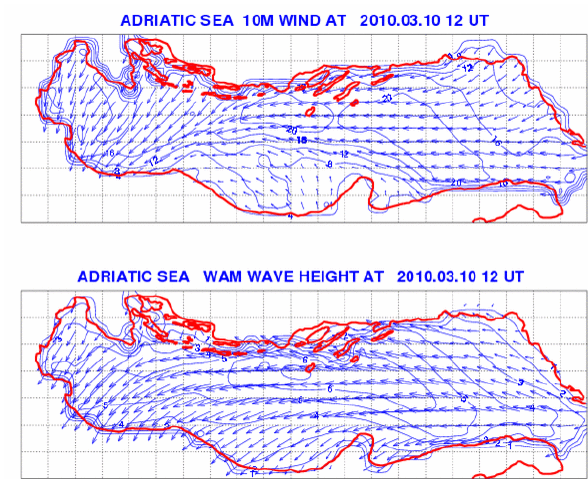
Figure 4 – Wind and wave fields in the Adriatic Sea at 12UTC 10 March 2010. Arrows show the Fig. 4. Wind and wave fields in the Adriatic Sea at 12:00 UTC, mean wind and wave directions respectively, with length proportional to wind speed and significant 10 March 2010. Arrows show the mean wind and wave directions, wave height. The isolines are traced at 4 m/s and 1 m intervals. For a more compact plot the respectively, with length proportional to wind speed and significant orientation is the one shown in Figure 3. wave height. The isolines are traced at 4ms − 1 and 1m intervals. For a more compact plot the orientation is the one shown in Fig.